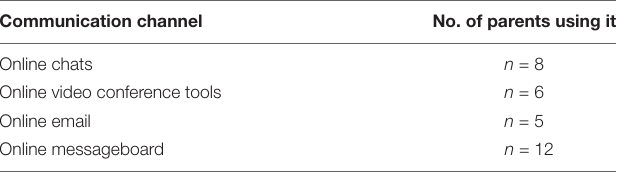
TABLE 1 | Communication channels and their uses.